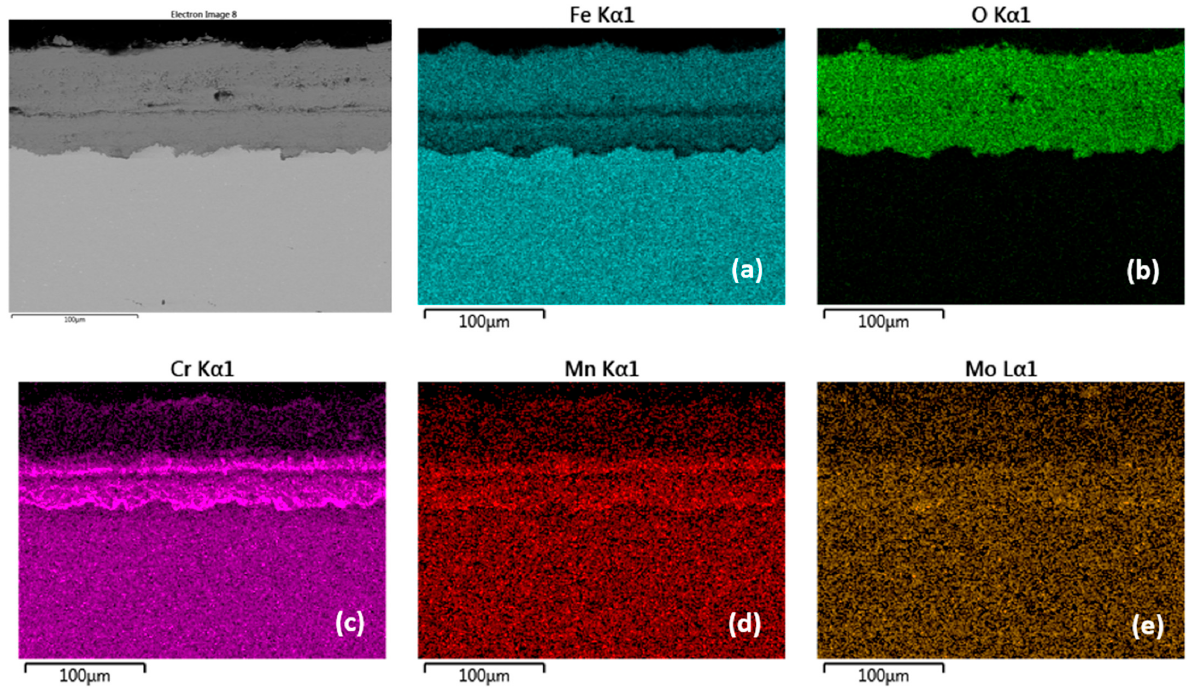
Figure 9. Cross-sectional SEM morphologies and EDS spectra analysis ( a – e ) of oxide films after oxidation for 2000 h, steel P91 at 650 °C.